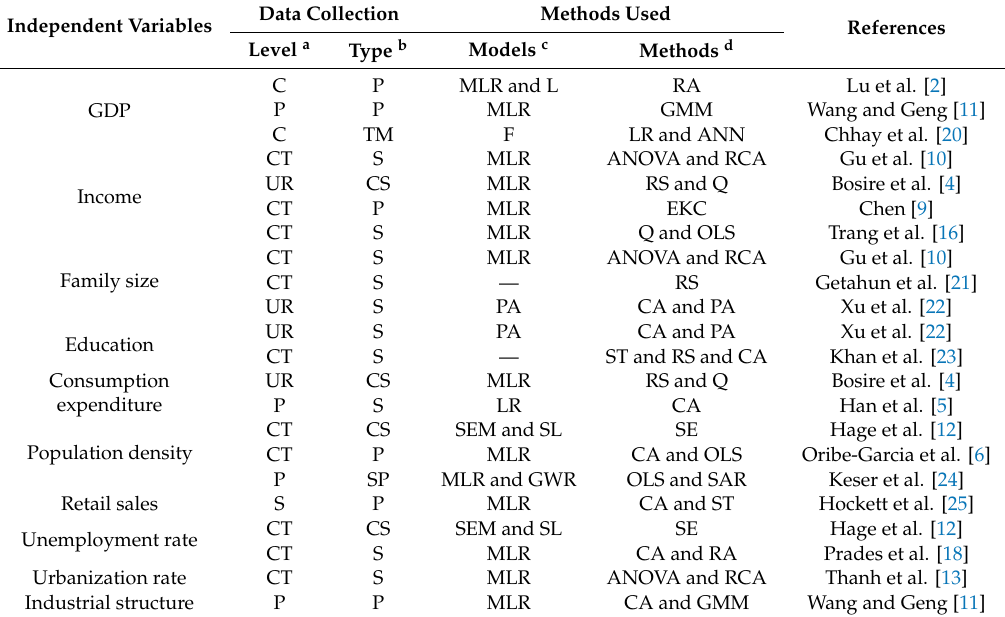
Table 1. Typical socioeconomic factors of municipal solid waste (MSW)